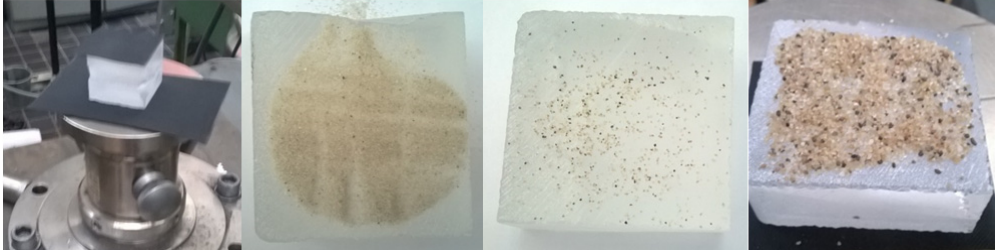
Fig. 11exploratory experiment with sand between contact surfaces of glass blocks; fine, medium and coarse